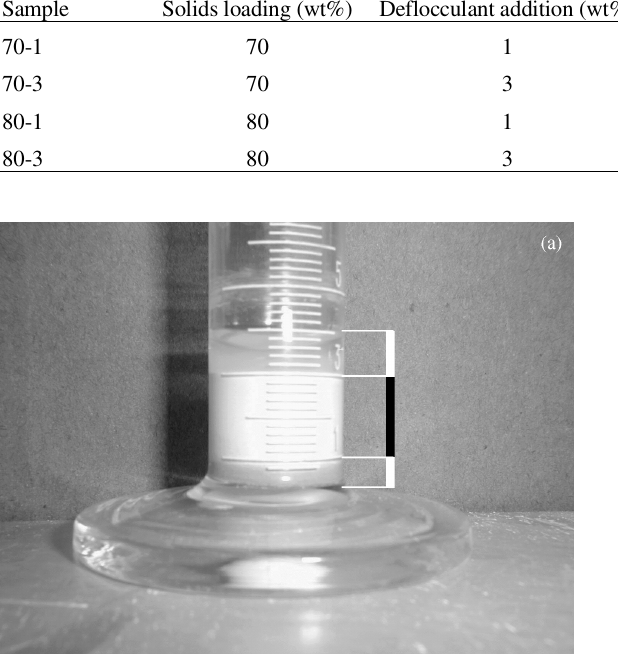
Table 1. Formulation of the suspensions used in this study and summary of experimental results. Sample